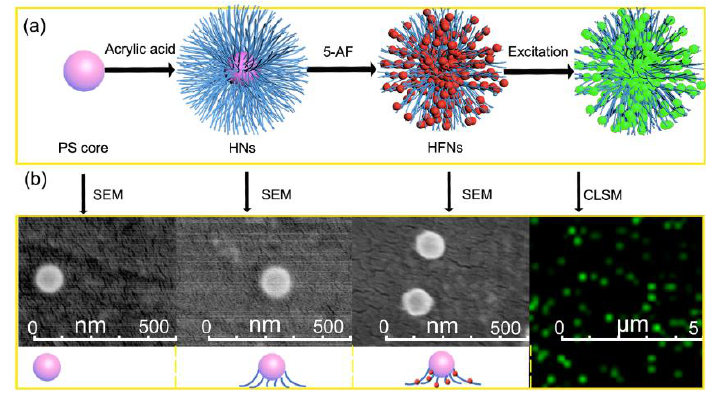
Figure 1. ( a ) Schematic illustration for preparation of hairy fluorescent nanospheres (HFNs); ( b ) Size and morphology of corresponding nanospheres characterized by SEM and confocal laser scanning microscope (CLSM, excitation with 488 nm excitation). 5-Aminofluorescein (5-AF).